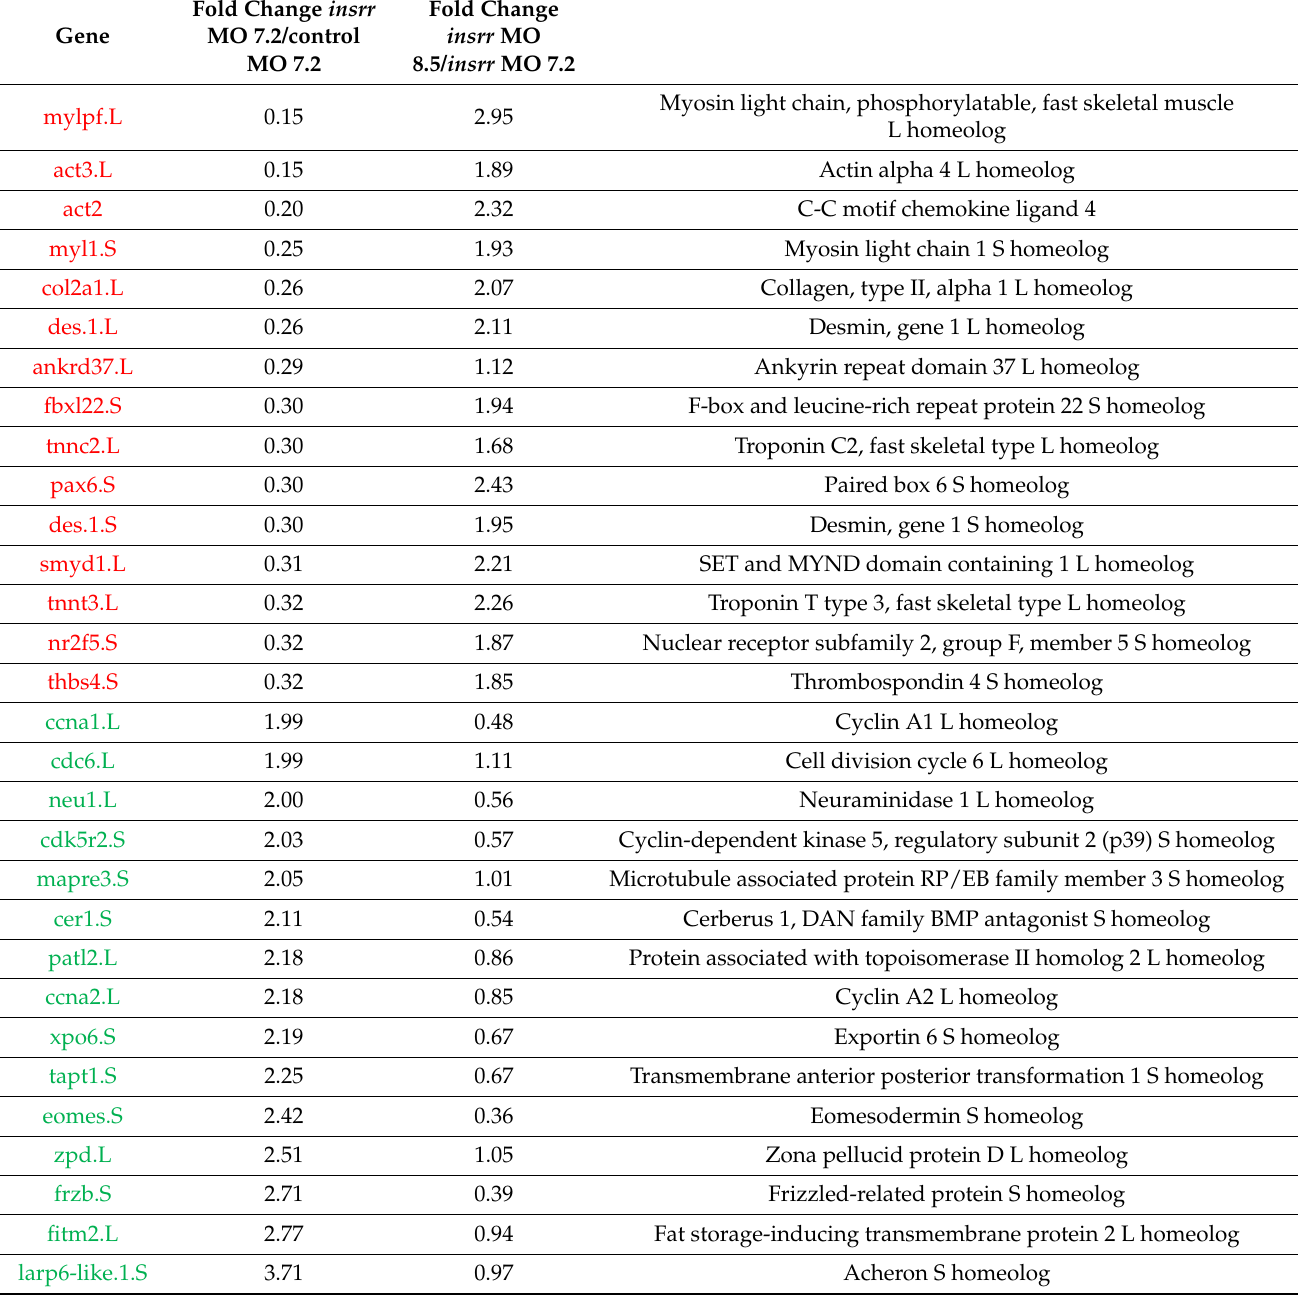
Table 1. Top 15 downregulated (red) and 15 upregulated genes (green) after MO1 injection into embryos at pH